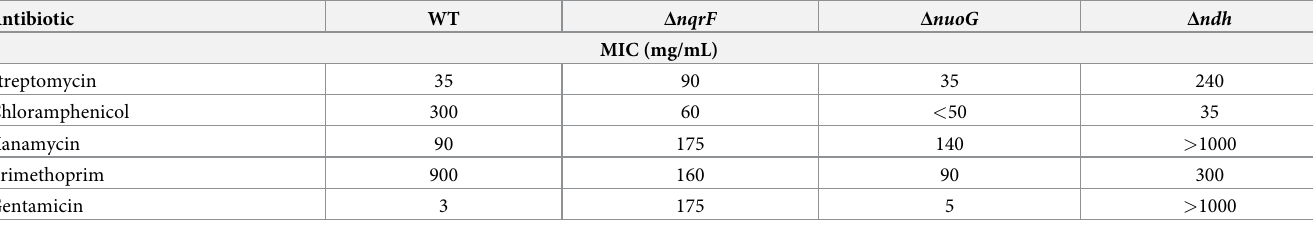
Table 3. Minimal Inhibitory Concentrations (MIC) a for wild type (PAO1), Δ nqrF , Δ nuoG , and Δ ndh .